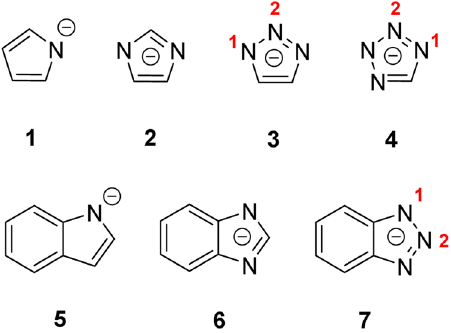
Figure 1. NHCs studied in this work. Multiple distinct SO 2 interaction positions are labelled by numbers in